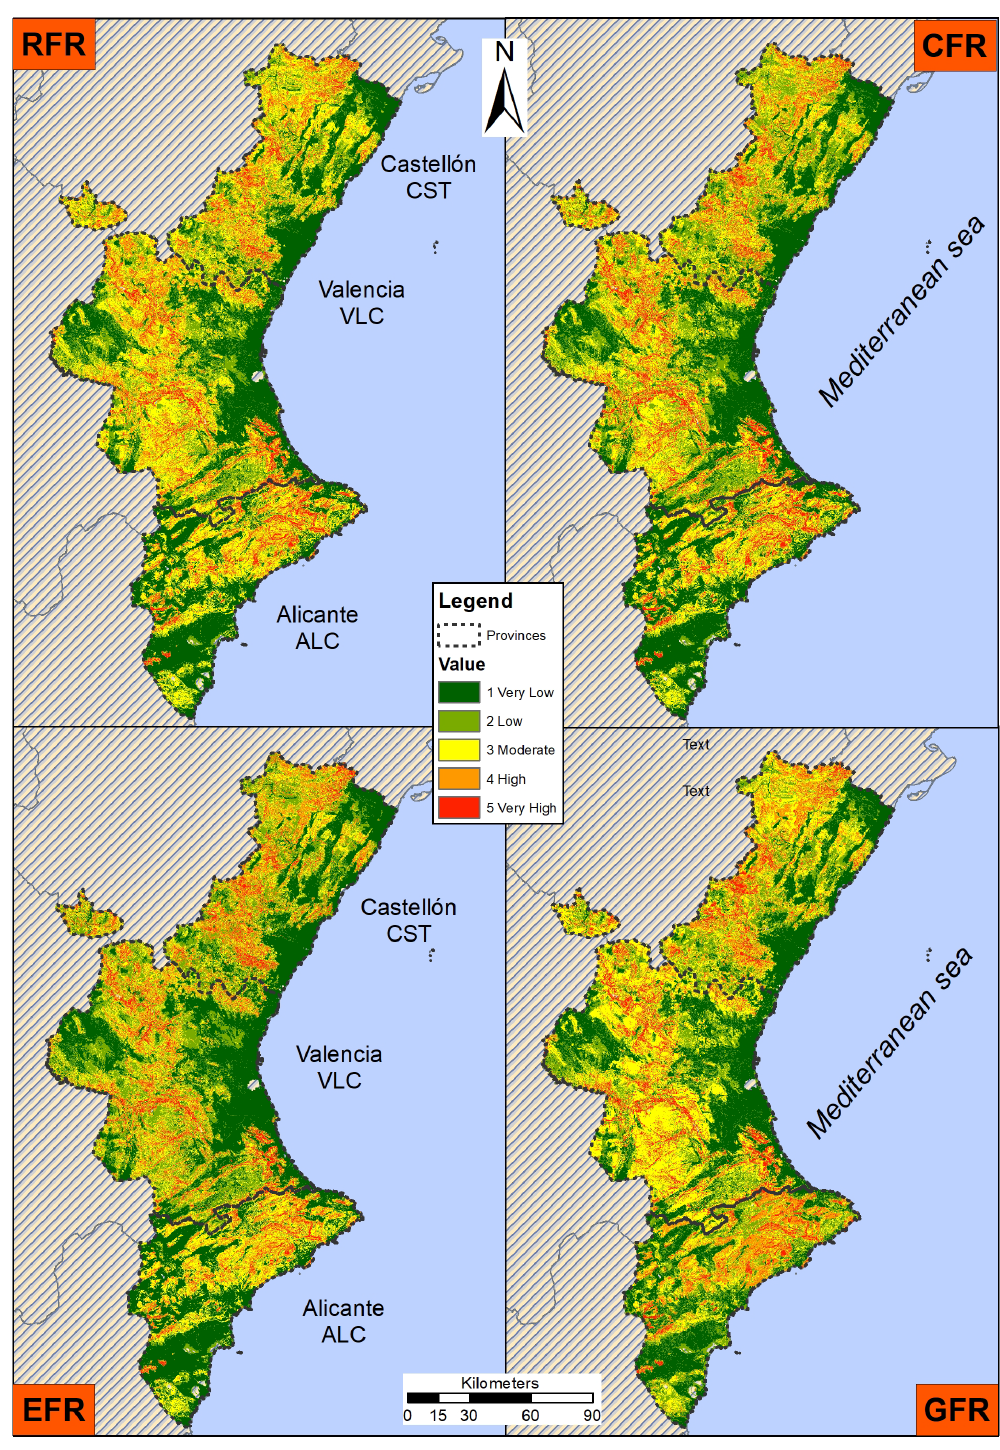
Figure A2. LSM with Generalised Youden classification.